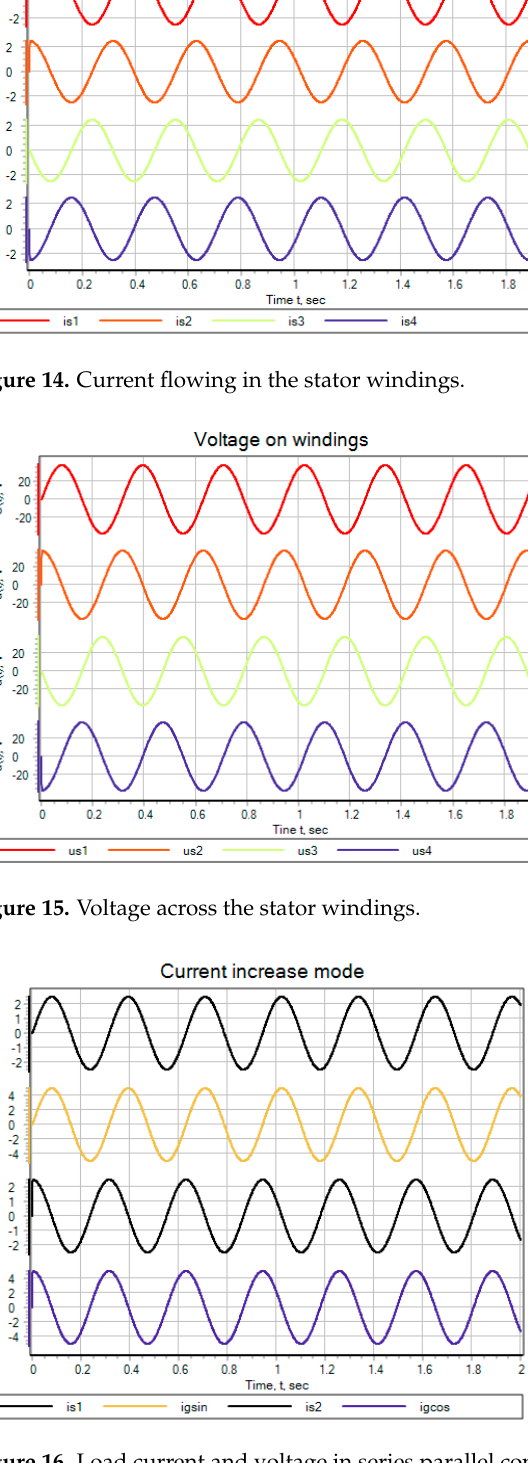
Figure 17. Voltage applied to the load when the stator windings are connected in series. Thus, according to Figure 16, when using a series-parallel connection of the stator windings in static mode, both the generated current and generated voltage are doubled. When all the windings are connected in series, according to Figure 17, the generated volt- age is quadrupled. Using the mathematical description presented above, we have to create a two-phase generator’s mathematical model (34)–(47), shown in Figure 18 [22]. Figure 18. Mathematical model of a two-phase generator.